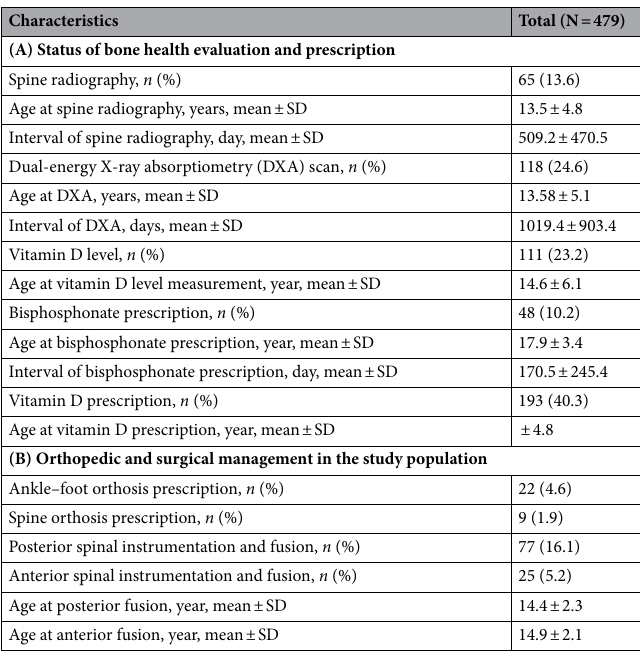
Table 2. Status of bone health management in the study population ((N = 479). Orthosis prescription data was extracted from 2016–2018. SD, standard